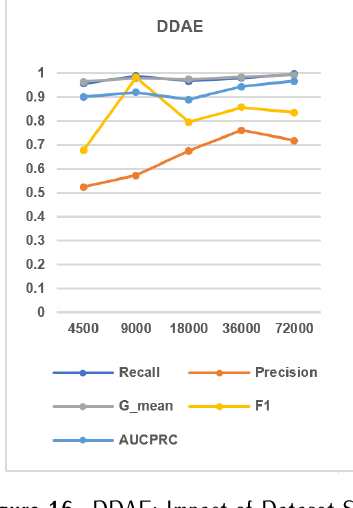
Figure 16. DDAE: Impact of Dataset Size